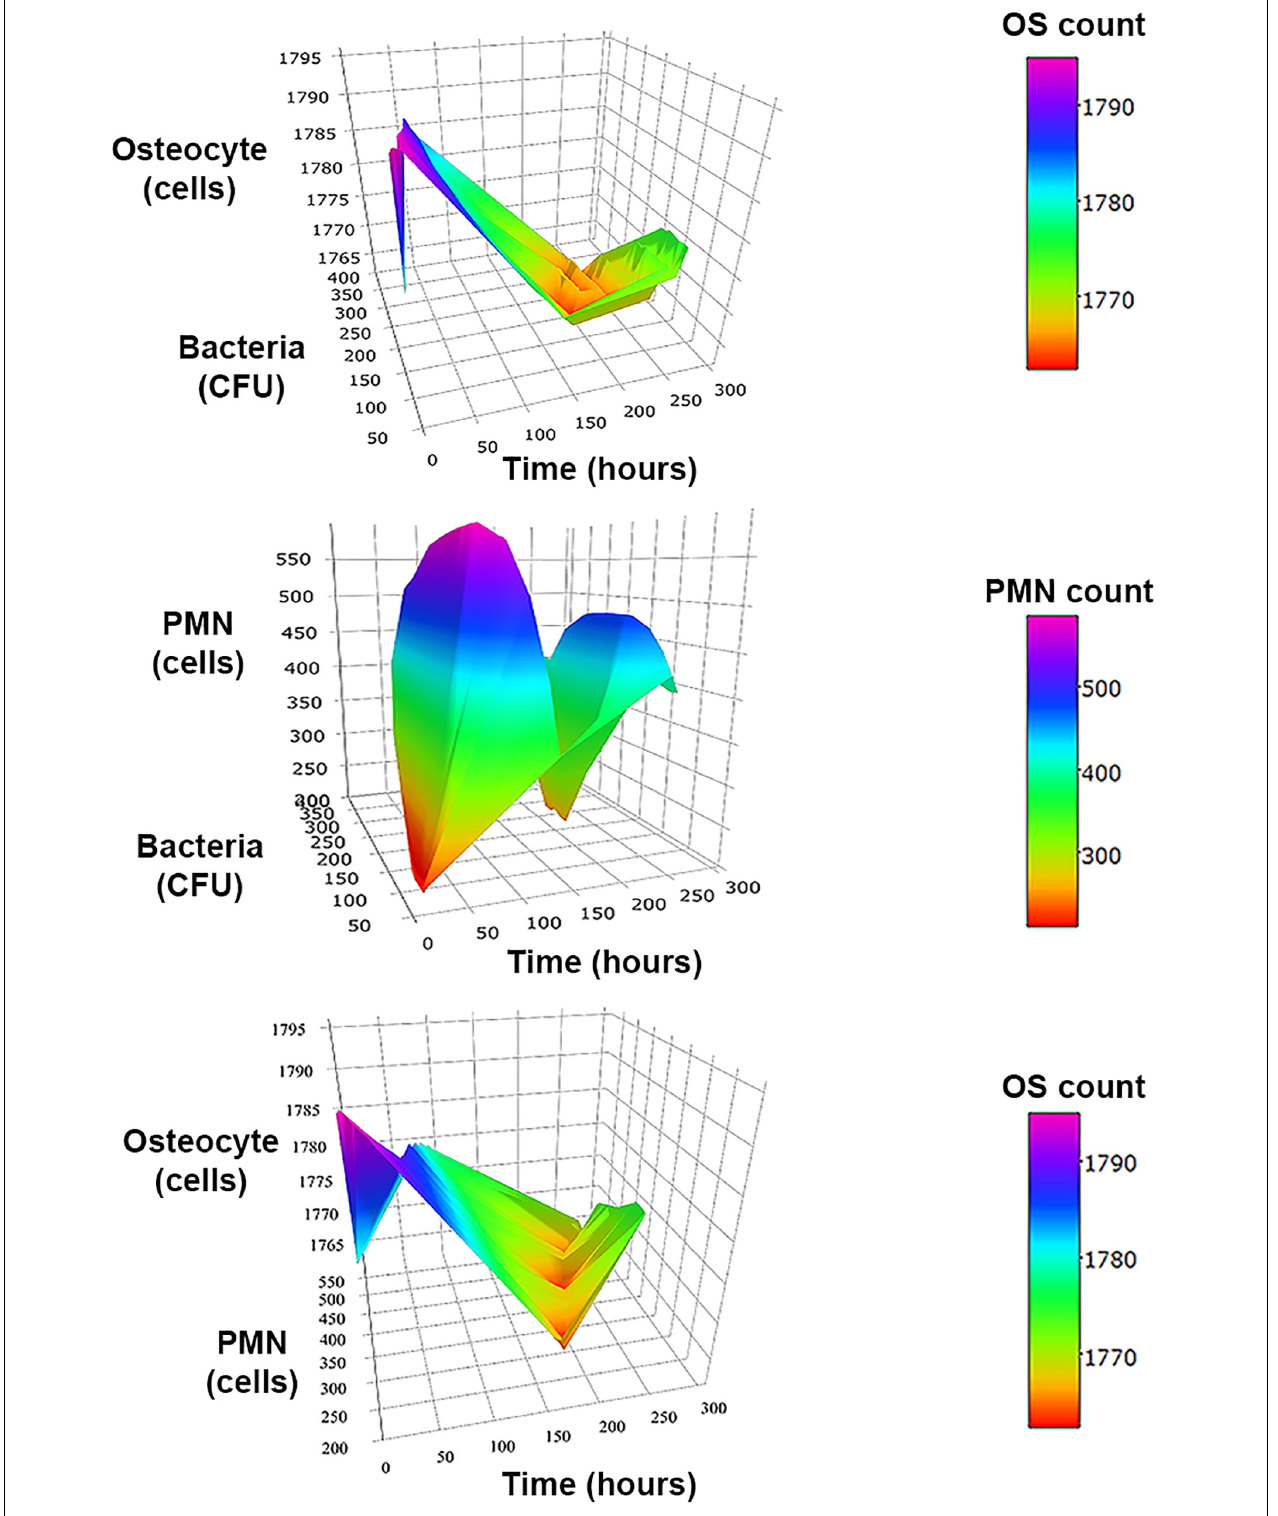
FIGURE 4 | 3D surface graphs to analyze the relationships between two types of agents over time at inoculum infection states of bacteria (50 CFU/mm 2 ). In the top, the graph shows the relationship between bacteria vs. osteocytes (OS) population over time for the three initial inoculum values. The second row corresponds to the osteocytes (OS) vs. neutrophils (PMN) population over time. The third row shows the relationship of neutrophils (PMN) vs. bacteria populations over time.